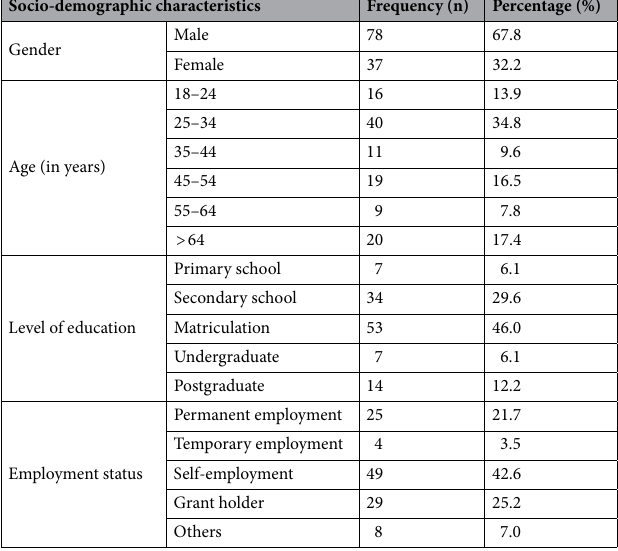
Table 1. Socio- demographic characteristics of the